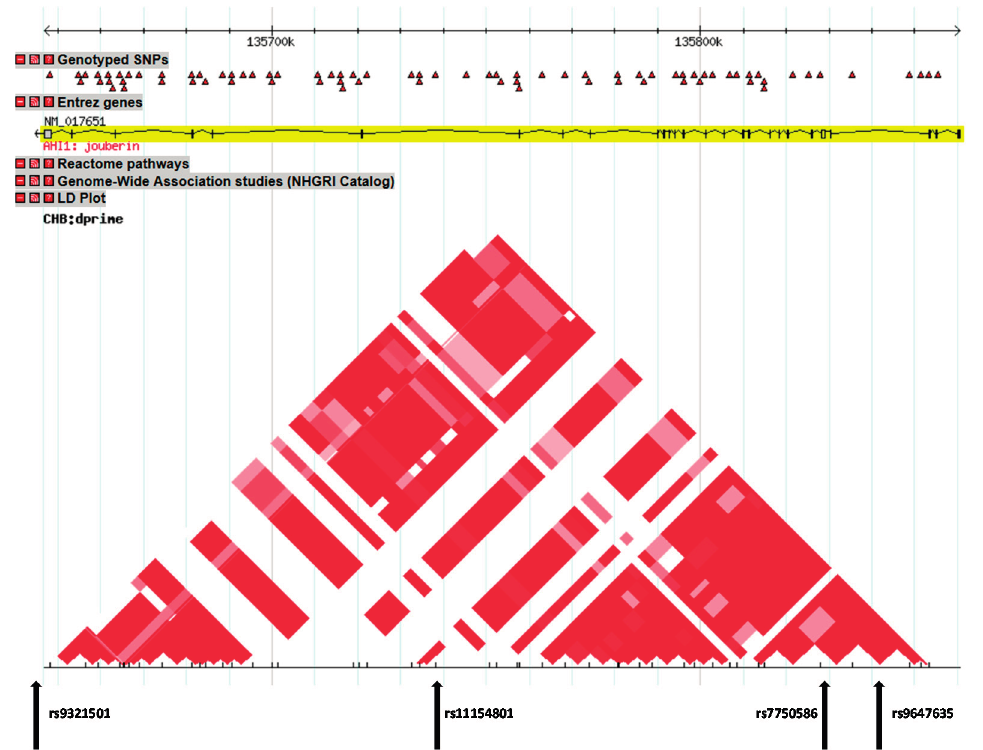
Figure 2. SNP positions on the AHI gene.